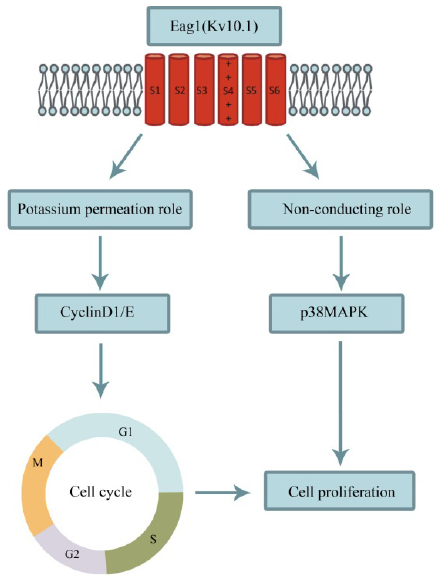
Figure 6. Schematic illustration of the role of Eag1 channel during OS cell cycle progression and